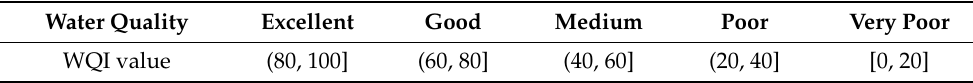
Table 2. Water quality classifications are based on WQI